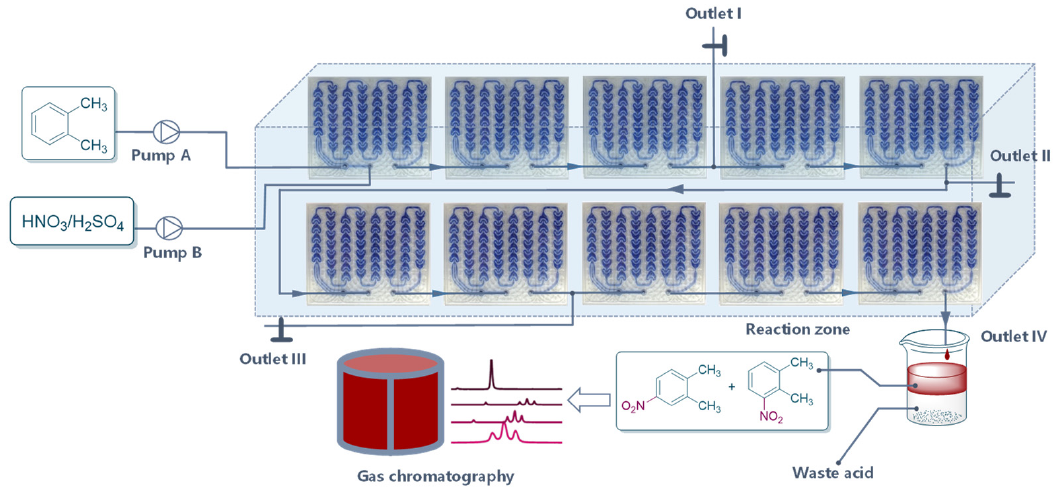
Figure 4. Continuous-flow reactor setup for the inspection of residence time.